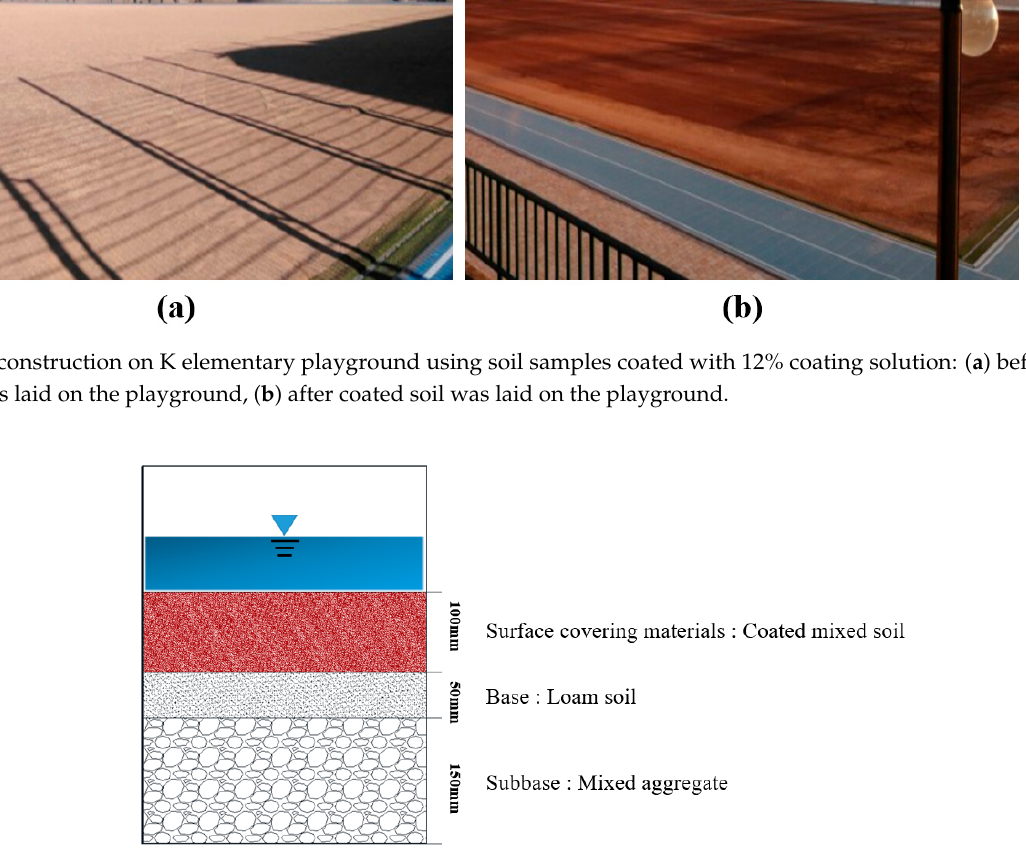
Figure 2. Site construction on K elementary playground using soil samples coated with 12% coating solution: ( a ) before coated soil was laid on the playground, ( b ) after coated soil was laid on the playground.